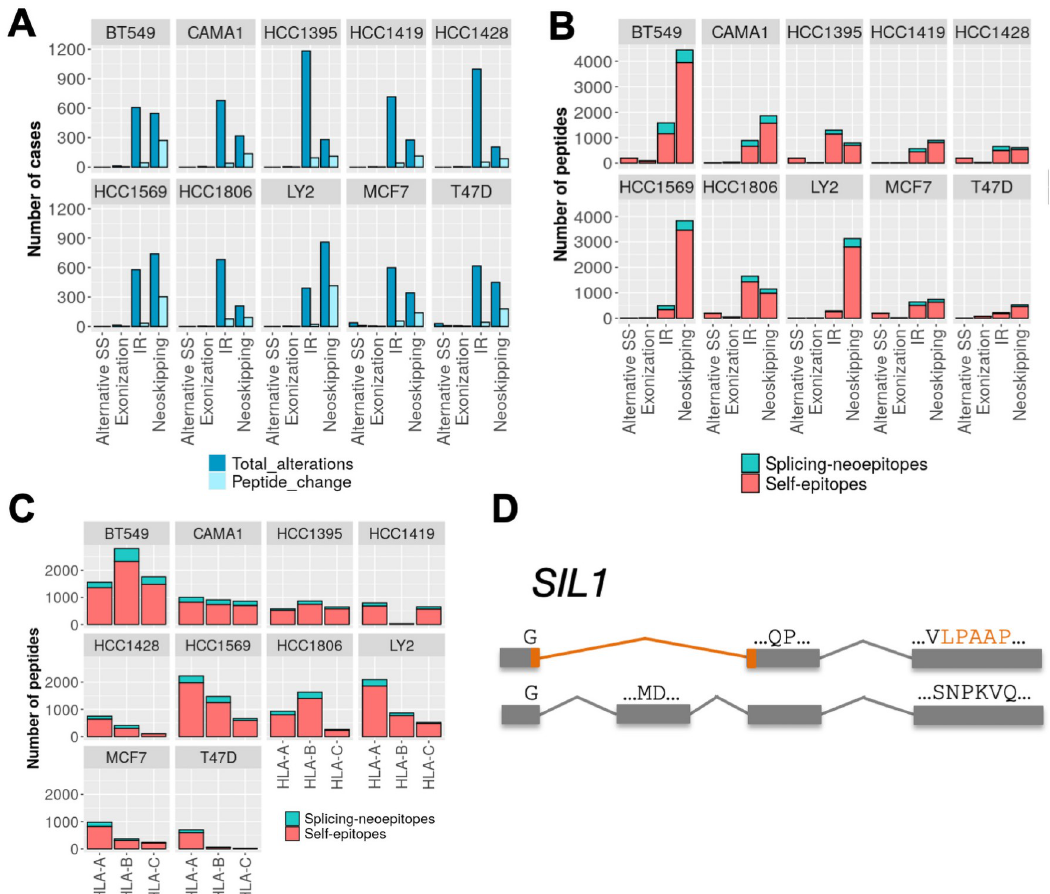
Fig 3. Splicing epitopes in ten breast cancer cell lines. (A) For each breast cancer cell line analyzed, the bar plots show the number of splicing alterations measured and the number of cases leading to a change in the reference protein. Alterations shown are alternative 5’ or 3’ splice-site (A5_A3), de novo exonizations (exonization), intron retentions (IR), and new exon skipping events (neoskipping). (B) Number of splicing-derived neoepitopes (splicing-neoepitopes) (red) and splicing-affected self-epitopes (self- epitopes) (blue) for each of the splicing alterations in each of the breast cancer cell lines tested. (C) as in (C) but separated by HLA- type. (D) Example of a splicing-derived neoepitope from a neoskipping event in the gene SIL1 validated with MHC-I associated mass spectrometry in the cell line